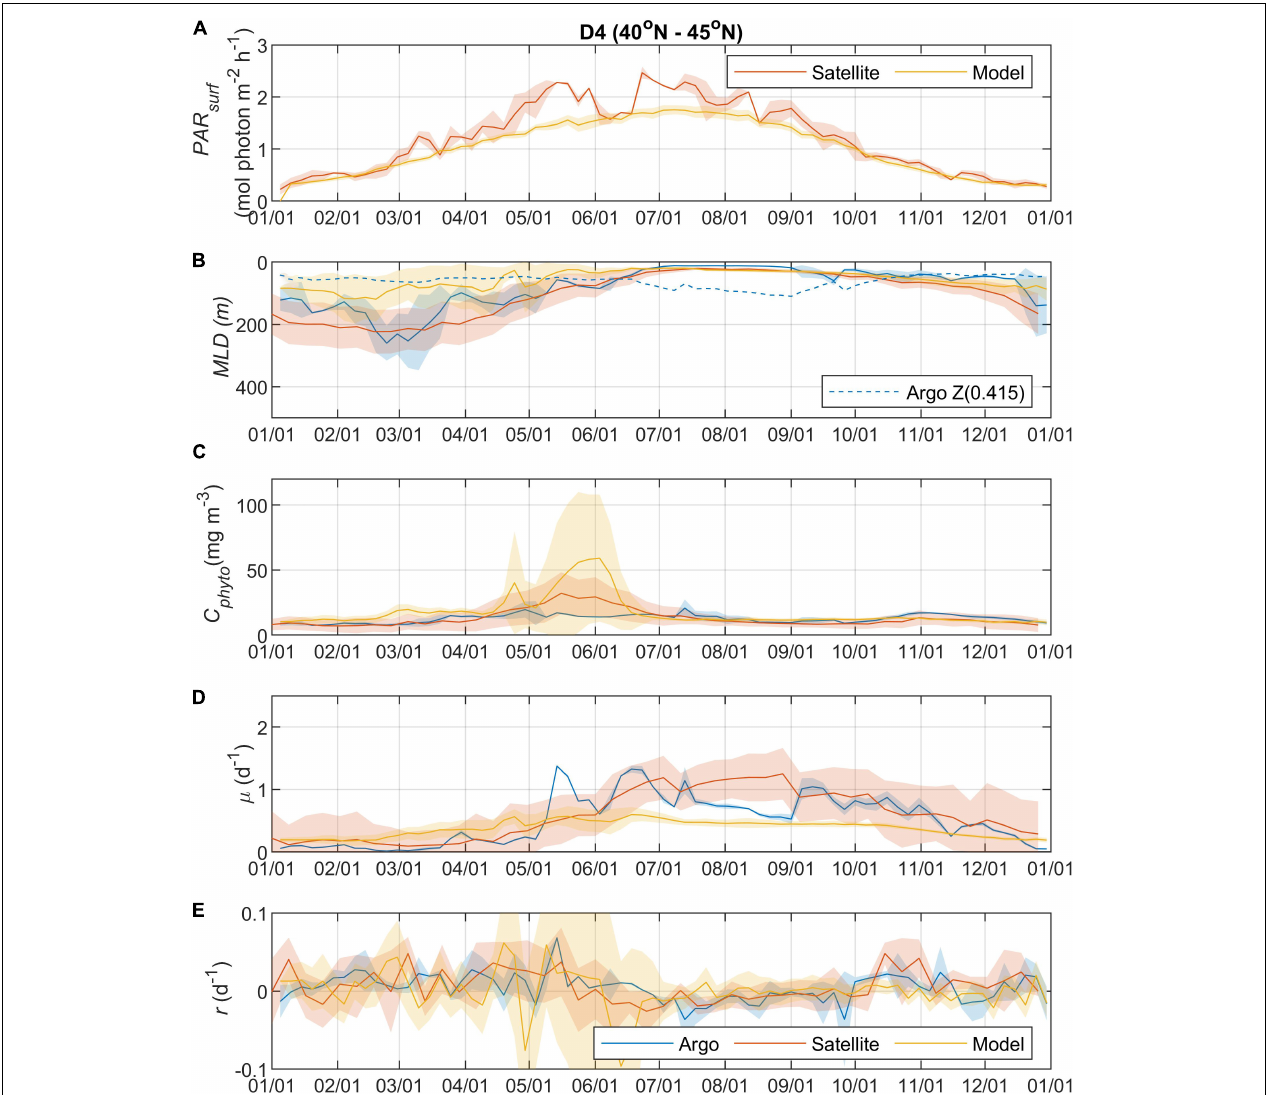
FIGURE 5 | Seasonal climatologies of (A) PAR surf , (B) MLD , (C) C phyto , (D) µ , and (E) r from Argo floats, satellite, and model simulation for region D4. See the caption of Figure 2 for